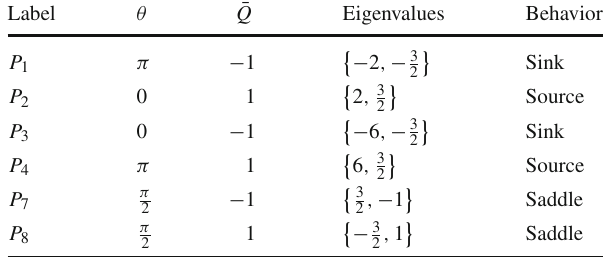
Table 1 Equilibrium points of system (144). The eigenvalues are obtained evaluating the linearization matrix of (144) at each point Label